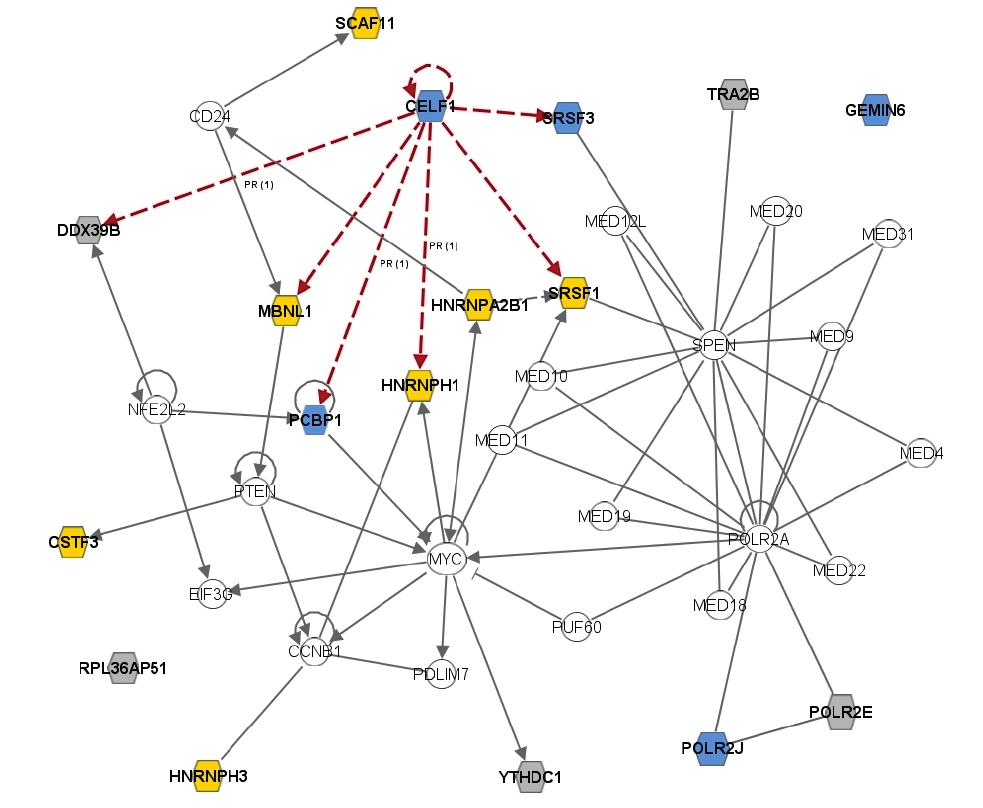
Figure 3. A single network includes most splice regulatory genes dysregulated in